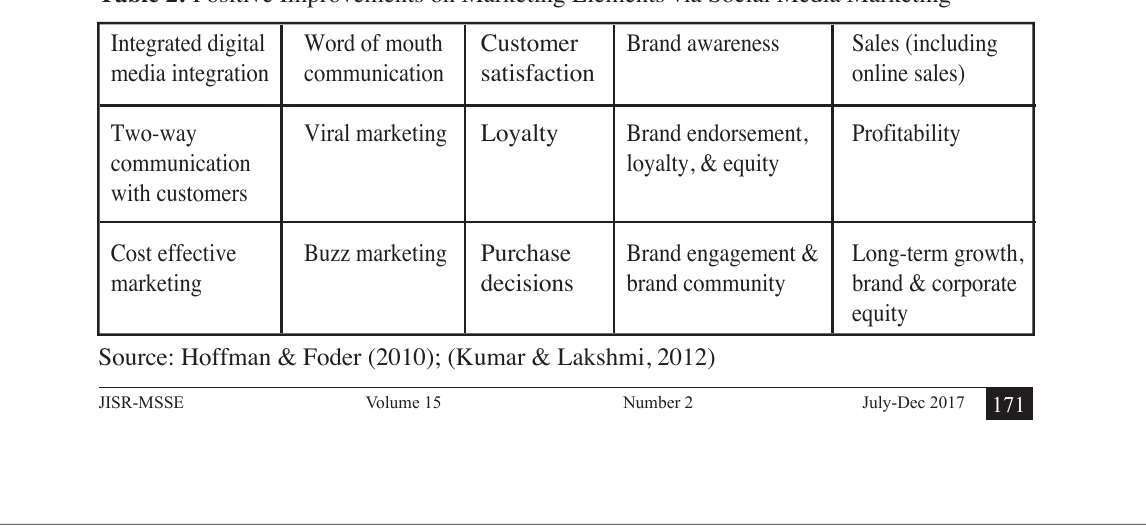
Table 2: Positive Improvements on Marketing Elements via Social Media Marketing